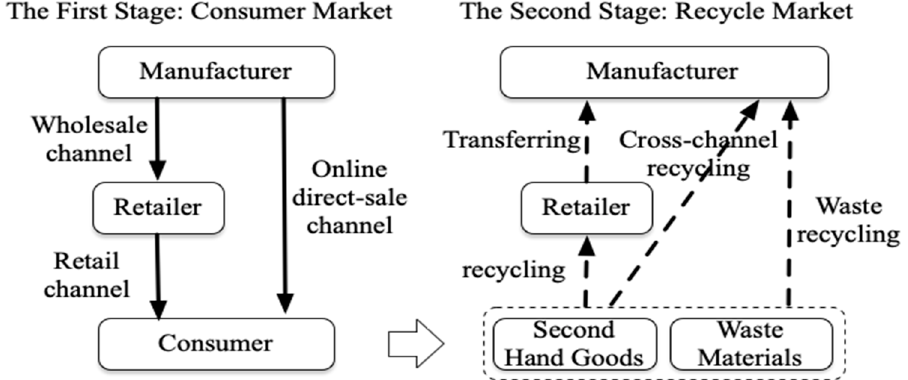
Figure 1. Two-stage CLSC structure considering cross-recycling channels.